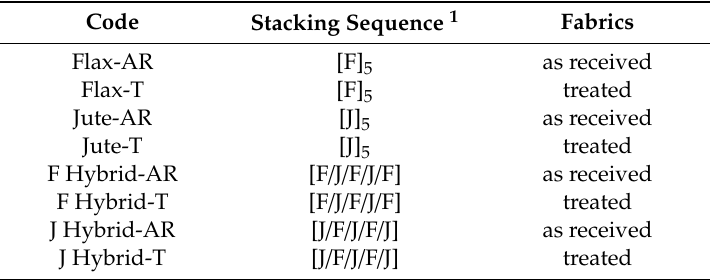
Table 1. List of composite